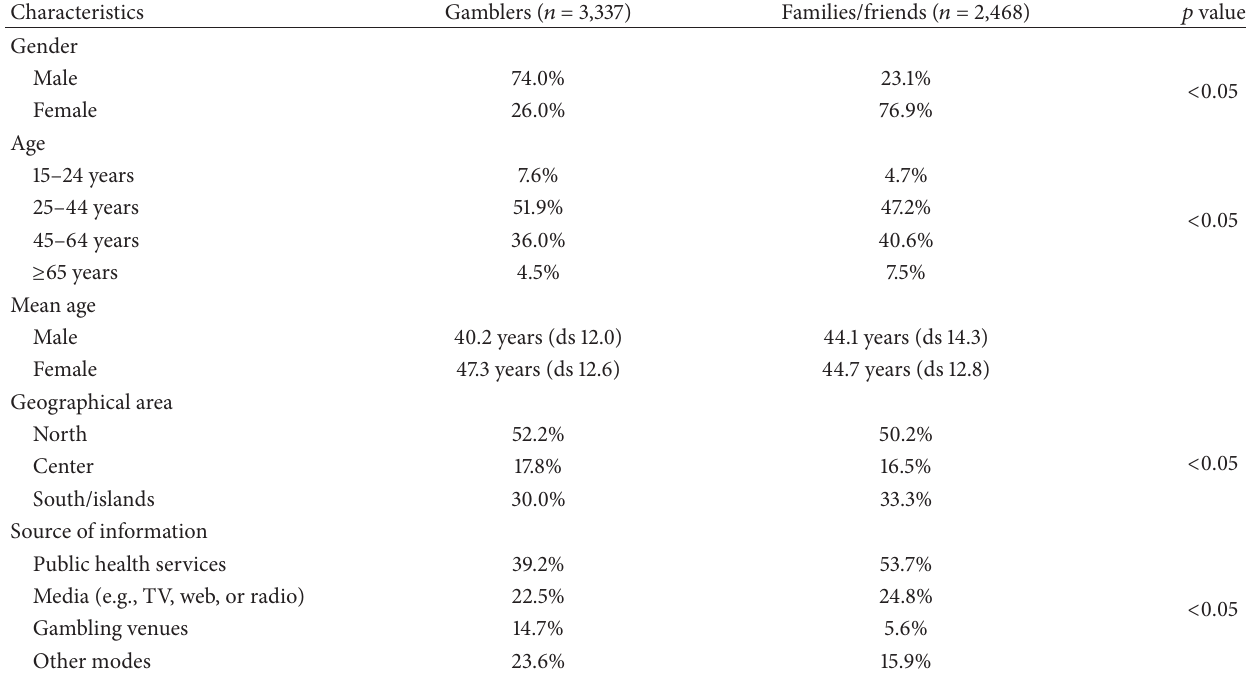
Table 1: Characteristics of gamblers and families/friends using